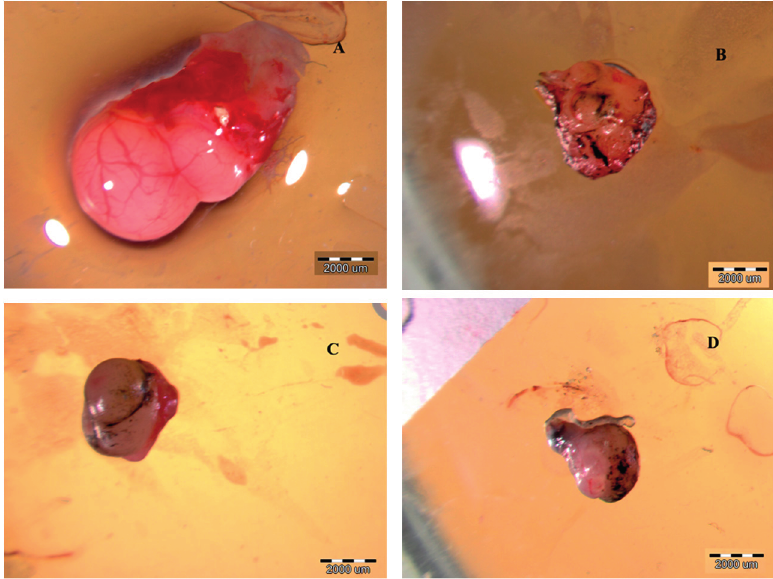
Figure 7. Morphology of U-87 glioblastoma tumors cultured on chicken embryo chorioallantoic membranes in the control group ( A ) and after treatment with reduced graphene oxide ( B ); reduced graphene oxide with arginine ( C ); and reduced graphene oxide with proline ( D